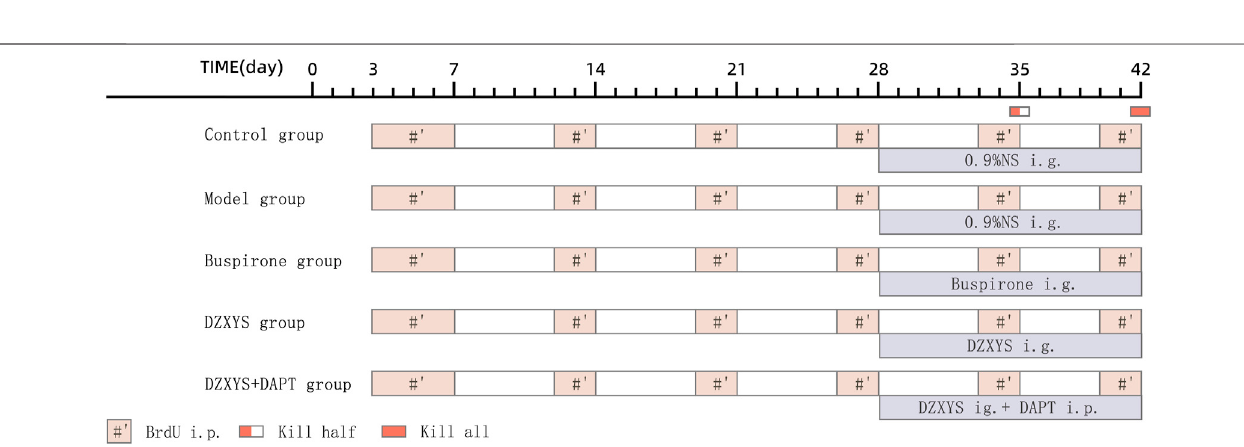
Frontiers in Pharmacology |